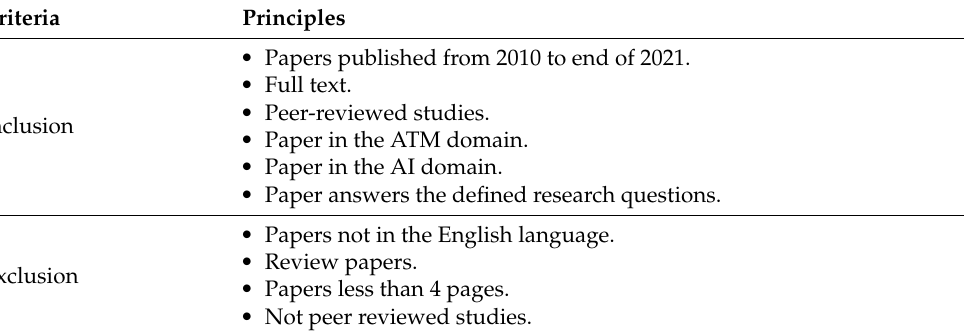
Table 1. Exclusion and inclusion